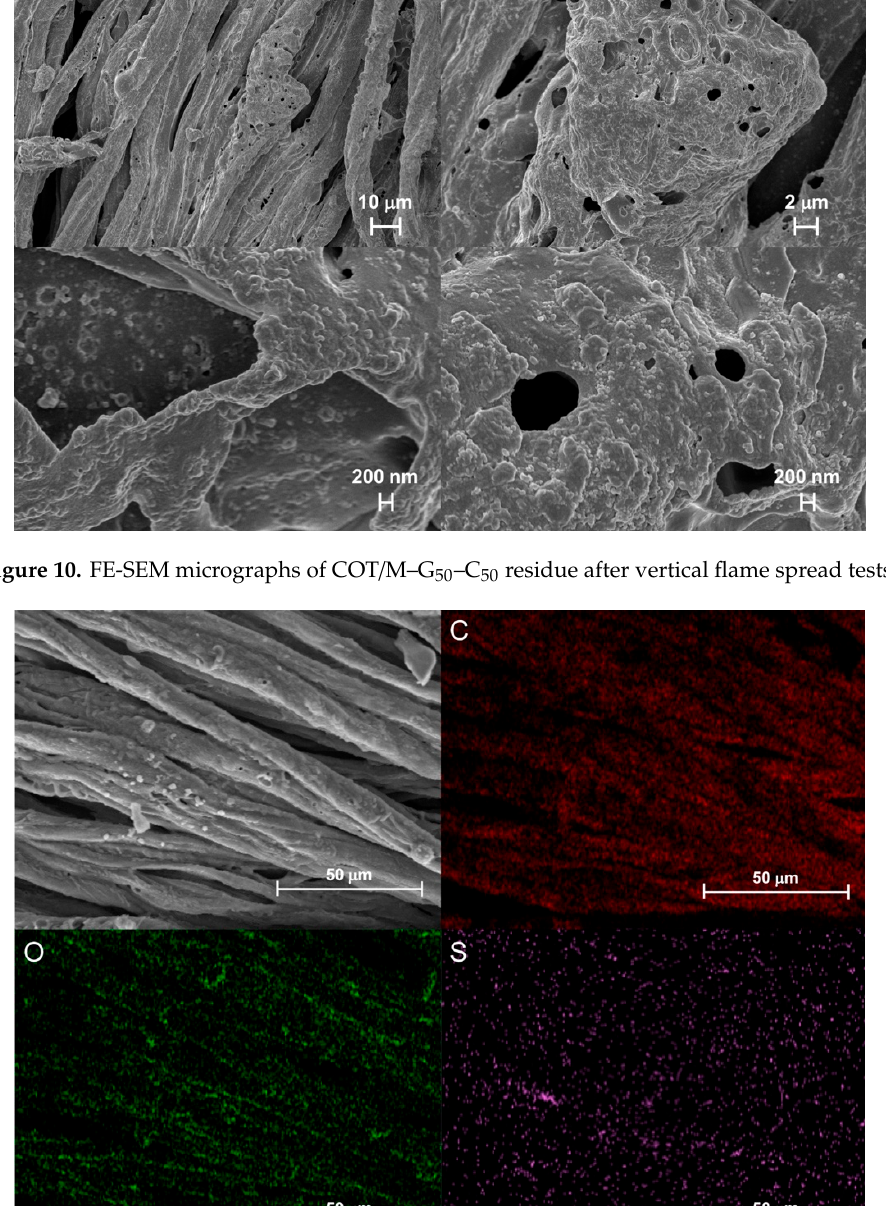
Figure 11. EDX analysis of COT/M–G 50 –C 50 residue after vertical flame spread tests. Distribution of carbon (C), oxygen (O), and sulfur (S).